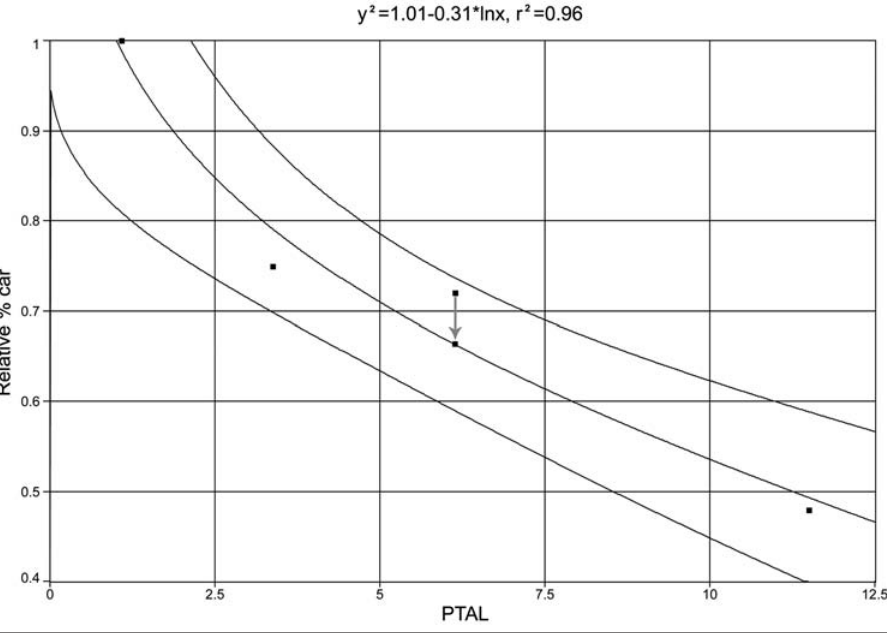
Fig. 5. Correlation between relative % car driver and